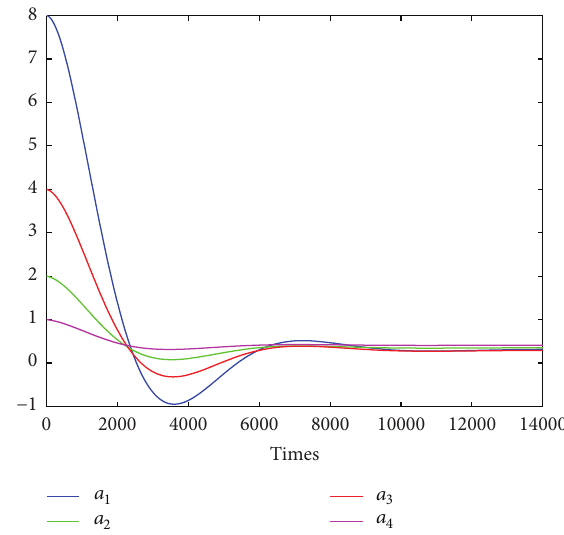
Figure 3: Estimated parameters of the controlled memristor chaotic oscillator